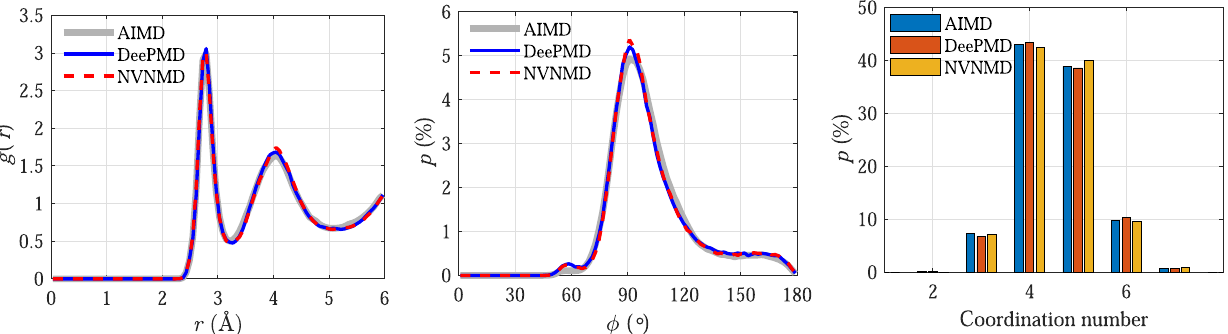
Fig. 2 The structure properties of amorphous GeTe. Radial distribution function (left), angle distribution function (middle), and coordination number (right) are computed by using AIMD, MLMD (e.g., DeePMD), and the proposed NVNMD.